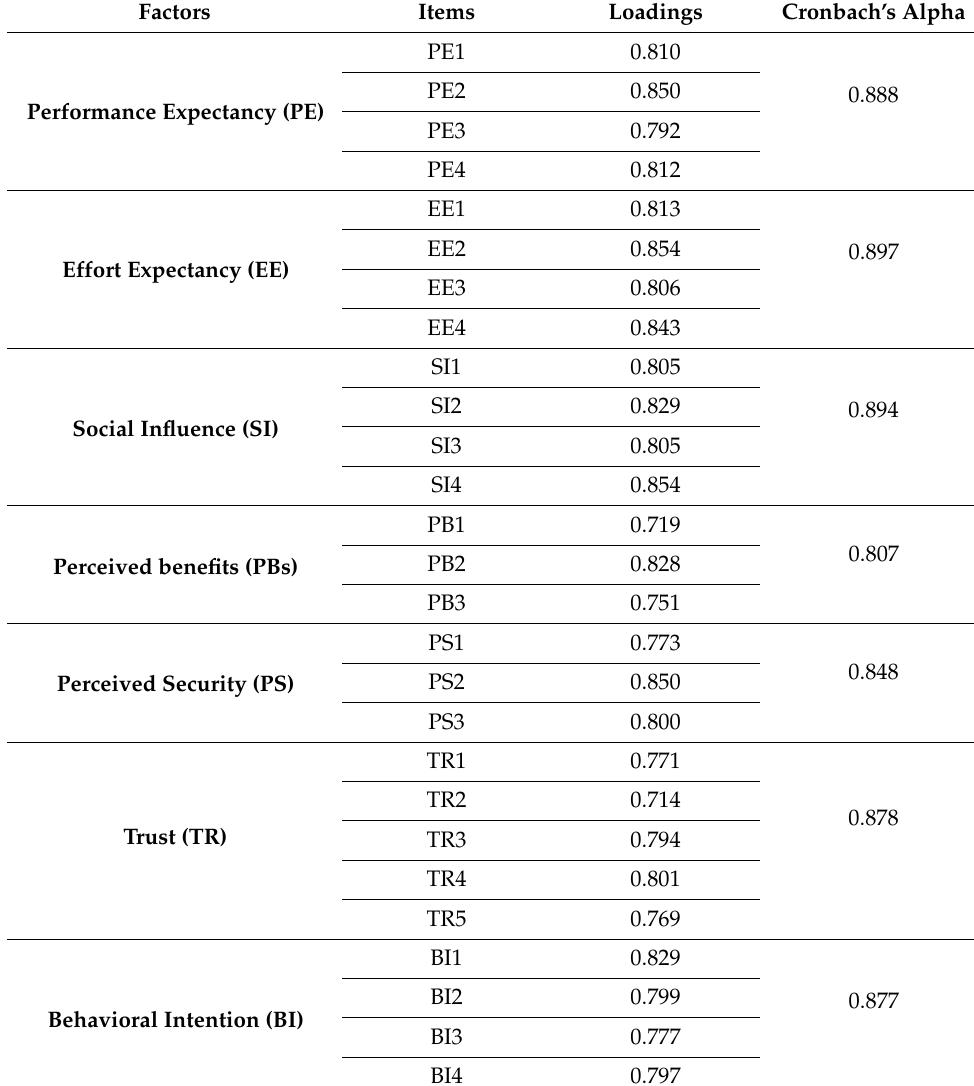
Table 3. Item loadings and Cronbach’s alpha of